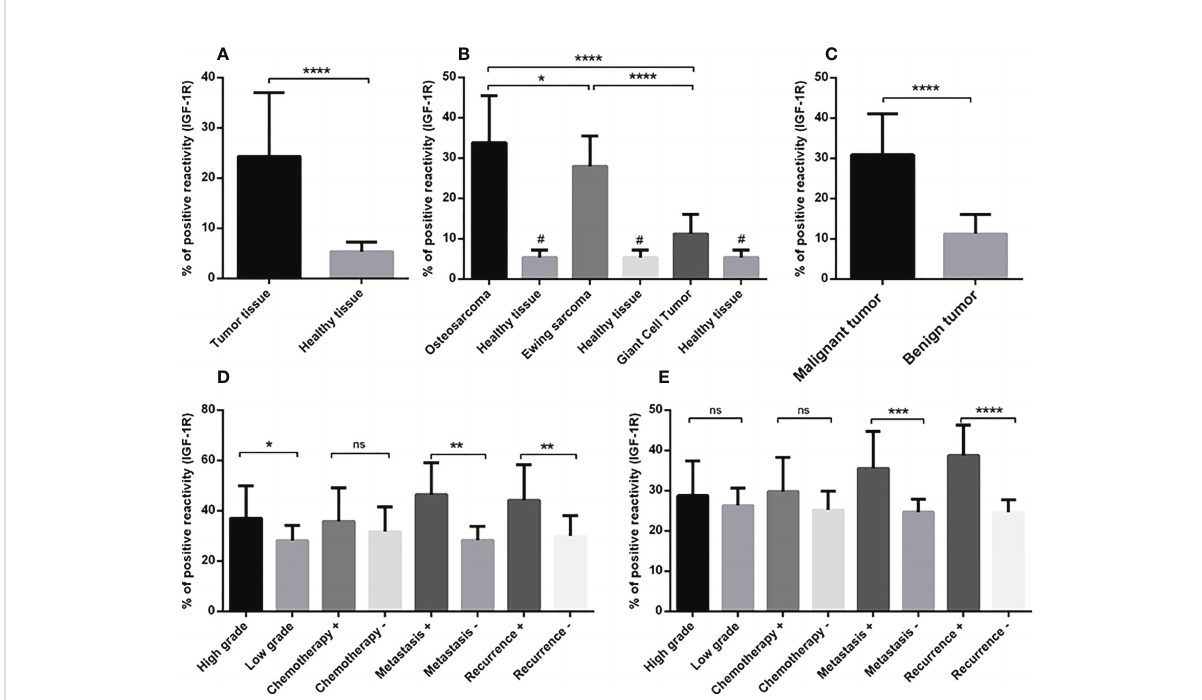
FIGURE 2 The IGF-1R protein expression level in primary bone tumors. The protein level of IGF-1R is represented as a positive reactivity percentage and the level was increased in bone tumors (N=90) versus tumor margins (N=90) (A) , also bone tumor subtypes versus adjacent noncancerous tissues (B) . The osteosarcoma tumors (N=30) expressed more IGF-1R protein compared to Ewing sarcoma (N=30) and GCT (N=30) (B) . The elevated level of IGF-1R protein in malignant tumors (N=60) versus benign tumors (N=30) is shown (C) . The elevated IGF-1R protein level is demonstrated in high-grade (N=19), metastatic (N=9) and recurrent (N=8) osteosarcoma tumors (D) and in metastatic (N=9) and recurrent (N=7) Ewing sarcoma tumors (E) . The number of examined samples in each tumor subtype is shown in Supplementary Table 1. The statistical differences between groups are shown as asterisks (*P <0.05, **P <0.01, ***P <0.001, ****P<0.0001) and (ns) indicates unspeci fi c. (#) indicates P<0.0001 for comparing osteosarcoma, Ewing sarcoma, and GCT with adjacent noncancerous